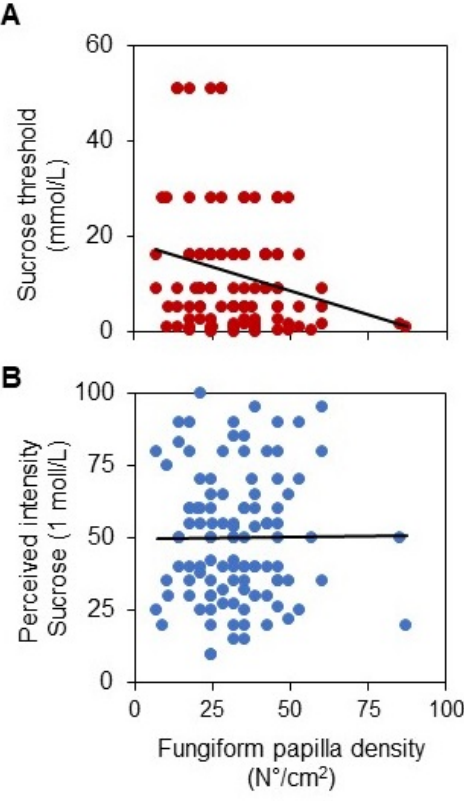
Figure 4. Linear correlation analysis between fungiform papillae density and the parameters describing sweet taste sensitivity . Relationship between the sucrose threshold and fungiform papillae density ( r = 0.231; p = 0.0168, Pearson linear correlation) ( A ). Relationship between the perceived intensity ratings after stimulation with sucrose solution (1 mol/L) and density of fungiform papillae ( r = 0.008; p = 0.932, Pearson linear correlation) ( B ). The mean values ± SEM of the sucrose threshold (mmol/L) and density of fungiform papillae (No./cm 2 ) in ST, MT, and NT are shown in Figure 5. One-way MANOVA showed that the sucrose threshold and density of fungiform papillae varied with PROP taster status (Wilks lambda = 0.88714, F (4, 206) = 3.1778, p = 0.01465). Post hoc comparison showed the sucrose threshold of ST was lower than that of NT ( p = 0.021; Duncan’s test subsequent